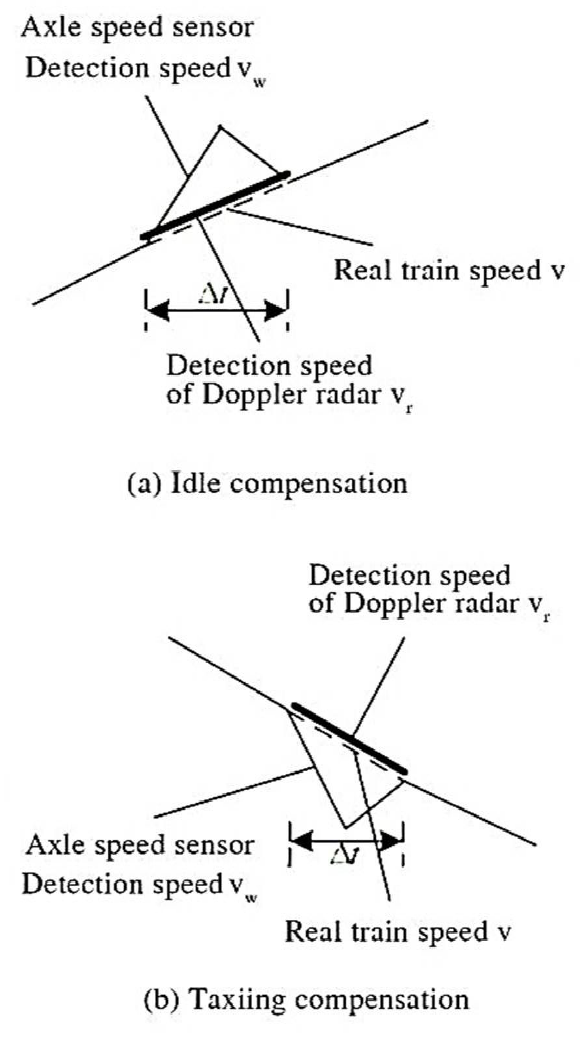
Figure 6: Schematic diagram of idling/taxiing compensation